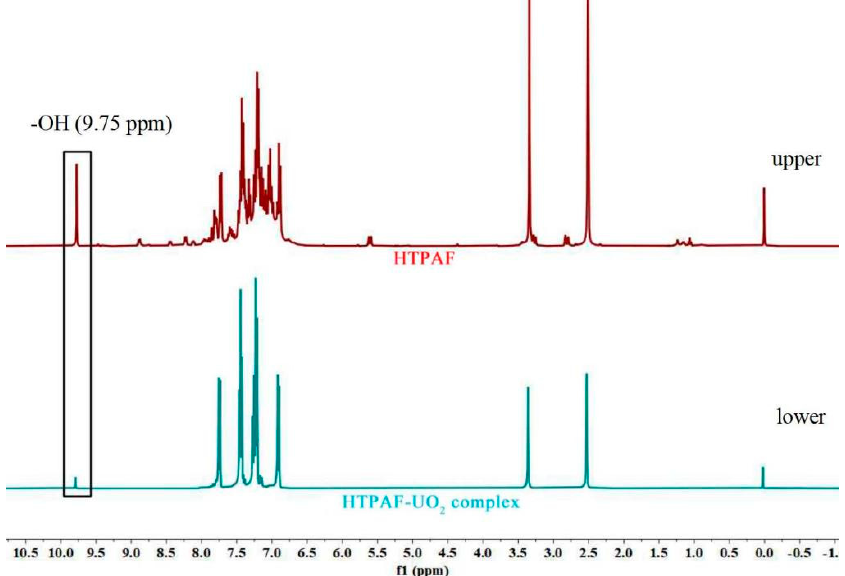
Figure 12. Comparison of 1 HNMR spectra of fluorescent probe HTPAF before (upper) and after (lower) addition of uranyl ions.